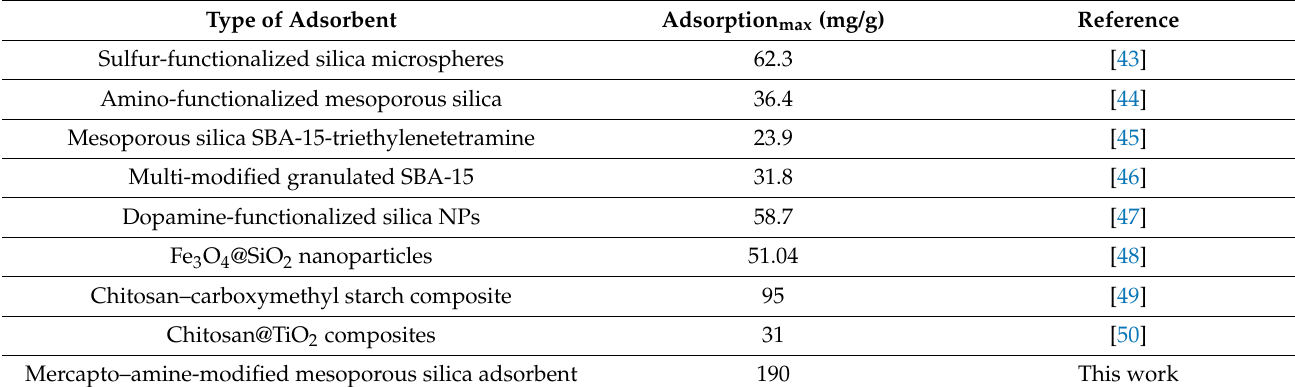
Table 3. Comparison of the adsorption capacity of the various functional adsorbent materials.